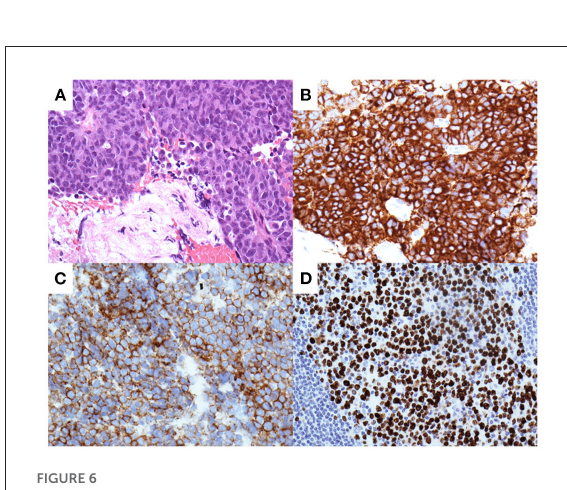
FIGURE6 Pathological analysis of the pancreatic tissues obtained by biopsy with per-oral pancreatoscopy. Hematoxylin and eosin staining show a marked proliferation of small round atypical cells with hyperchromatic nuclei and scanty cytoplasm (A) . Immunohistochemical analysis shows tumor cells positive for synaptophysin (B) and CD56 (C) . Tumor cells demonstrate a Ki-67 labeling index of 90% (D)